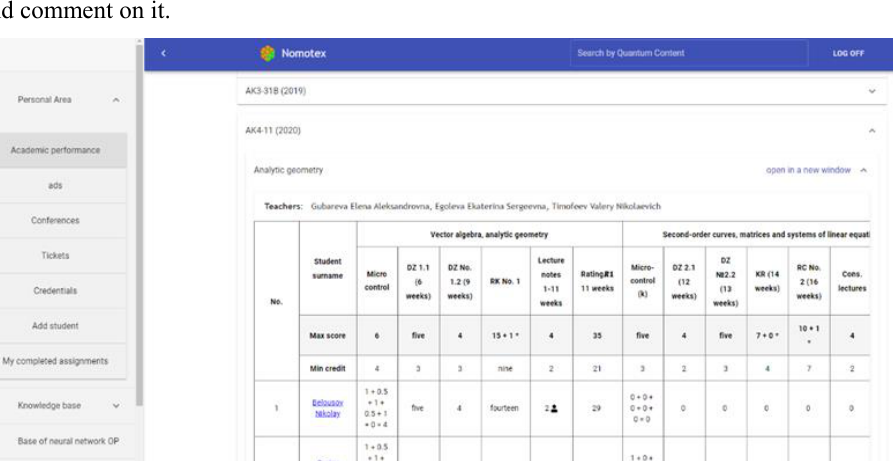
Fig. 6. Window of the subsystem «Teacher's personal account (rating of students)» in the Nomotex